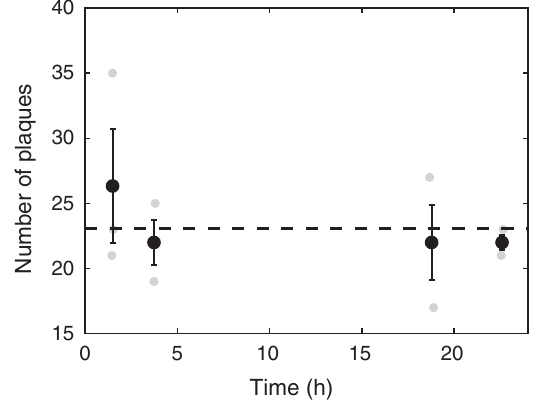
FIG. 7. Plaques counted on the surface of a 2% agar plate as a function of the time after the phage are originally added to the plate. Data for the four time points measured (black) and their corresponding errors are calculated from three replicates (gray). The dashed line indicates the mean number of plaques counted across time points. It can be seen that the data are consistent with a constant number of phage being recovered over time, indicating that phage diffusing into the agar are very limited.